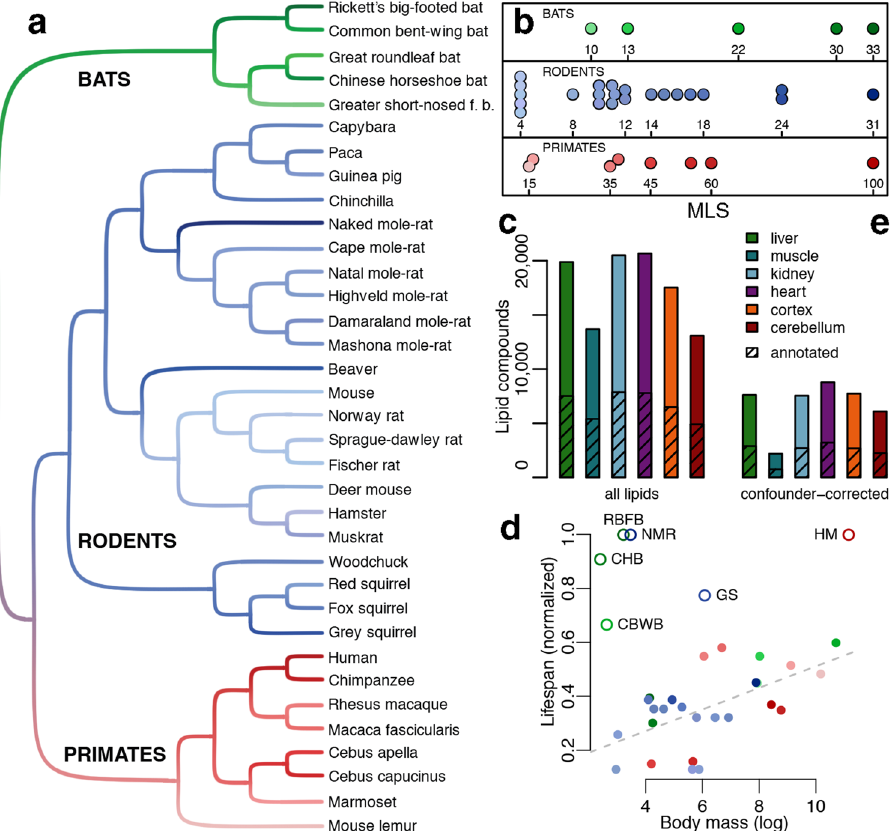
Figure 1. Dataset. ( a ) Phylogenetic tree of the 35 species used in this study. Colors show the clade identity and the MLS of species, with darker shades representing longer MLS. ( b ) Species’ MLS distribution in years. Each dot represents a species. Colors are as in panel a. ( c ) Number of lipid compounds measured in each tissue. ( d ) Relationship between species’ MLS and body mass. The colors are as in panel a. Open circles indicate species deviating from the linear relationship between MLS and body mass. The dashed line shows linear model fit to the remaining species (F-test, p < 0.05). MLS was normalized to the maximal MLS value within each clade. NMR – naked mole-rat, HM – human, GS – grey squirrel, CBWB – common bent-winged bat, RBFB – rickett’s big-footed bat, CHB – chinese horseshoe bat. ( e ) Number of lipid compounds of each tissue after removal of the compounds related to the confounding